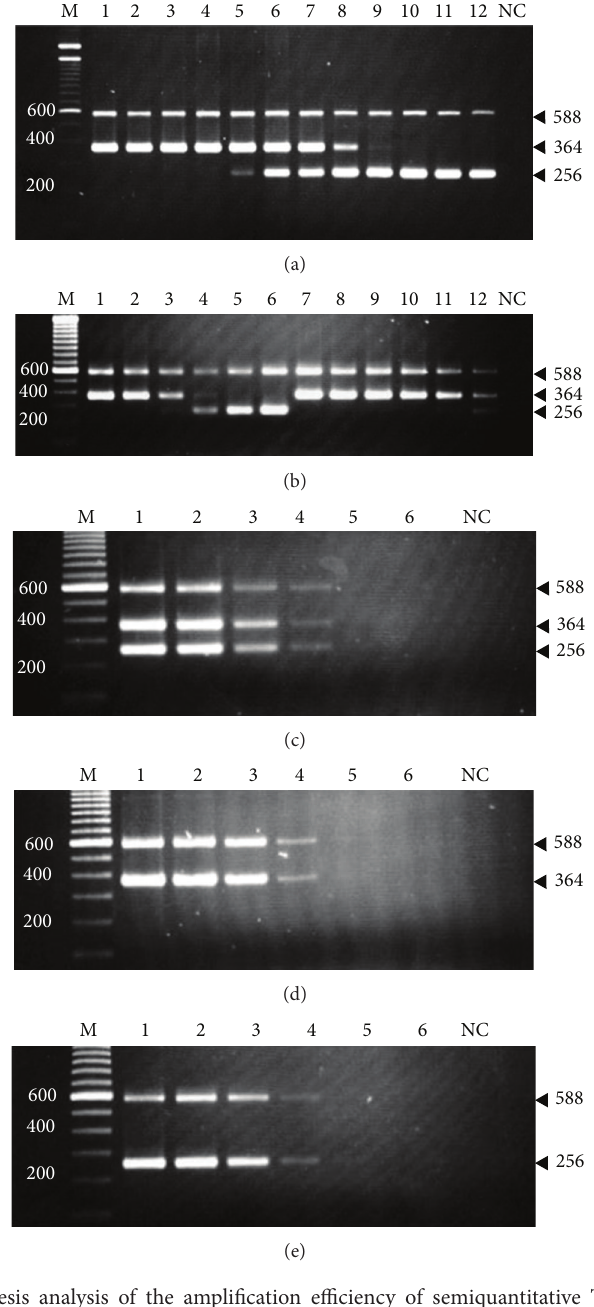
Figure 3: Agarose gel electrophoresis analysis of the amplification efficiency of semiquantitative TMPCR. A reciprocal amplification algorithm of detectable levels of the O1 to O139 gDNAs (experiments (a) to (e)) was described in the text, while E. coli gDNA template serving as negative control (NC) was included. (a) Lanes 1 to 6, the 100 ng O1 gDNA versus a 10-fold serially diluted O139 gDNA, 1pg to 100ng, and vice versa (lanes 7 to 12). (b) Lanes 1 to 3, unequal amount ratios of the O1: O139, 100ng to 1 pg, 10 ng to 10 pg, and 1ng to 100 pg, and vice versa (lanes 4 to 6). Lanes 7 to 12, the 100 pg O139 gDNA versus the O1 gDNA contents of varying 100 ng, 50 ng, 25 ng, 10ng, and 1ng to 100pg. (c) Lanes 1 to 6, the equal amount ratios of 10-fold serially diluted O1 to O139 gDNAs, 100 ng to 1pg. (d) Lanes 1 to 6, 10-fold serially diluted O1 gDNA contents, 100ng to 1pg. (e) Lanes 1 to 6, 10-fold serially diluted O139 gDNA contents, 100 ng to 1pg. A 100 bp DNA ladder marker (lane M) was used in comparison of the amplicons with expected size